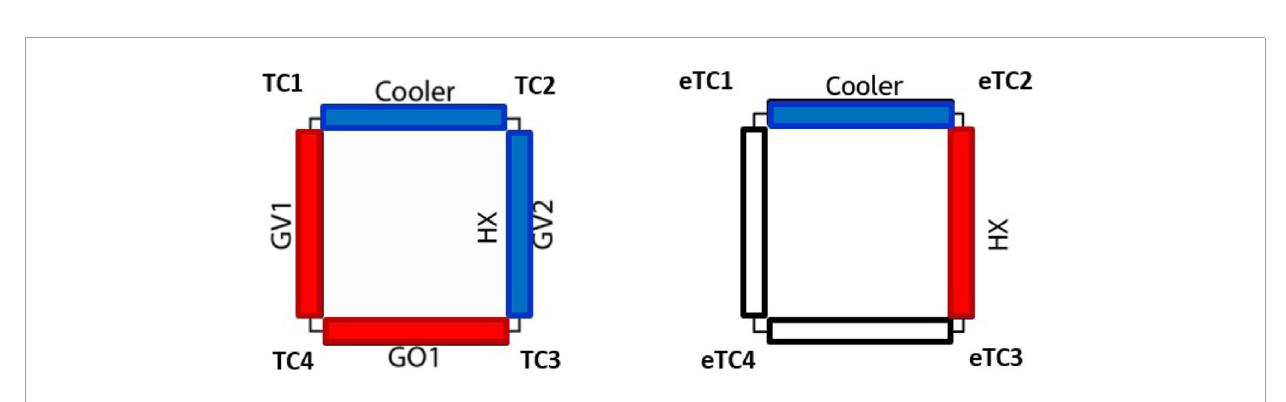
FIGURE 9 Schematic view of the coupled facility model temperature sensor